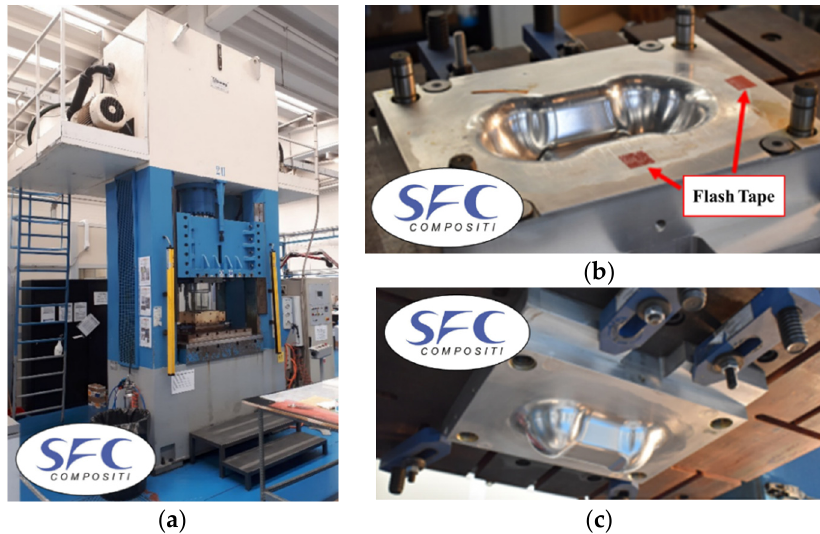
Figure 9. Vertical press Sick 30-FGS ( a ), Double Dome mold: top ( b ) and bottom ( c ).